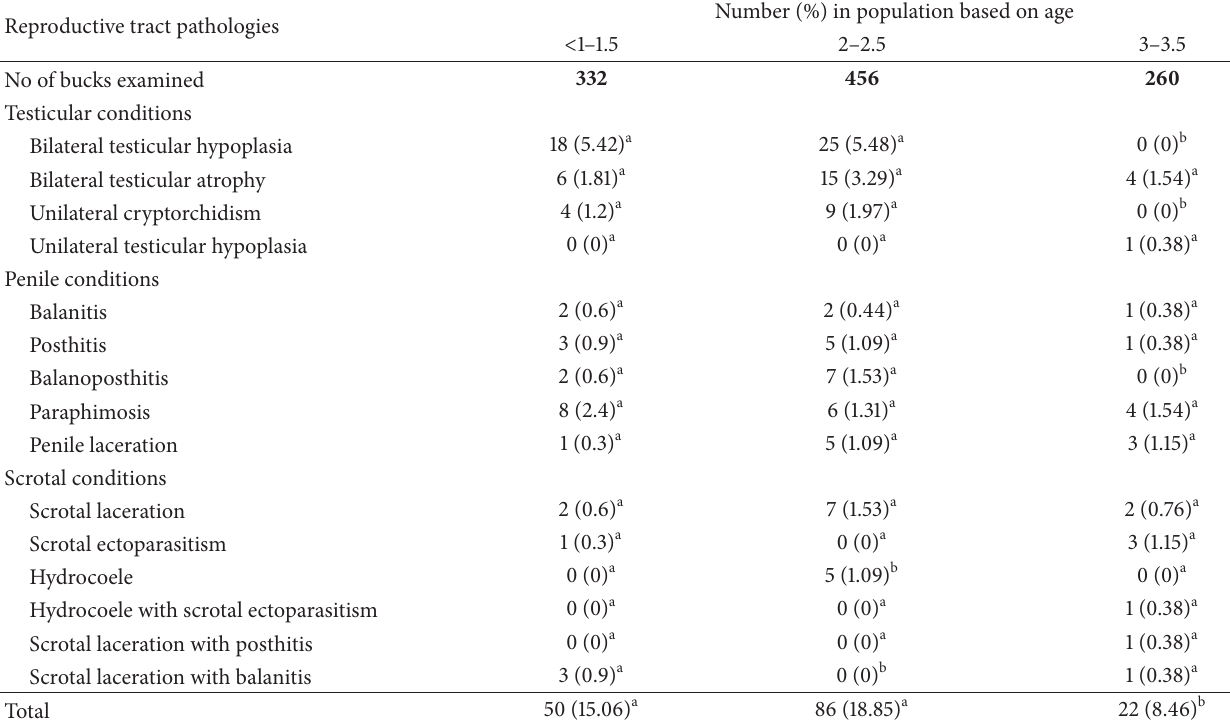
Table 2: Age specific incidence of pathological conditions in the male reproductive tracts of Sahel goats. Reproductive tract